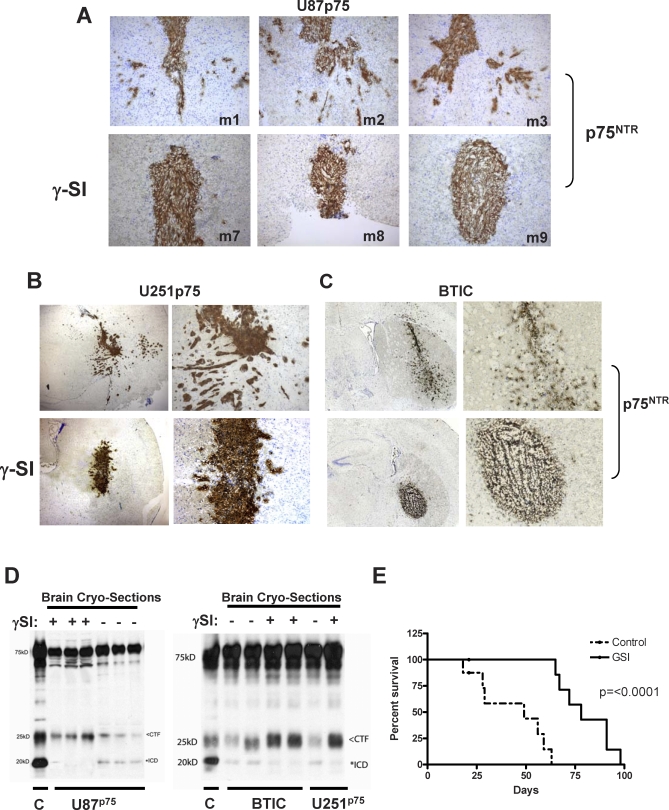
γ-Secretase Inhibitor Significantly Blocked p75NTR Induced Glioma Migration and Invasion In Vivo(A–C) u87p75NTR (A), U251p75NTR (B), or p75NTR-positive BTICs established from a patient GBM specimen (C) were implanted intracerebrally into SCID mice (m1–m3 and m7–m9 represent individual mice). Three days (U87p75NTR and U251p75NTR) or 5 d (BTIC) later, mice were administered s.c. 10 mg/kg γ-secretase inhibitor DAPT (γ-SI) or vehicle (corn oil) alone, once/day for 2–3 wk (three to five mice/group). The mice were sacrificed, and frozen brain sections were stained with an antibody against human p75NTR (brown). Sections were counterstained with toluidine blue to visualize the cell nucleus (blue). Control animals given vehicle alone (corn oil; middle row) developed tumors with highly infiltrative edges (top panels). In marked contrast, animals that received daily injections of the γ-secretase inhibitor DAPT (bottom panels) developed localized tumors with demarcated edges. Similar results were seen in two independent experiments with three to five animals in each group.(D) γ-Secretase inhibitor blocks p75NTR processing in vivo. Brain cryosections from three individual SCID mice implanted with u87p75NTR-, U251p75NTR-, or p75NTR-positive BTICs and administered s.c. 10 mg/kg γ-secretase inhibitor DAPT or vehicle (corn oil) alone were lysed in 2× loading buffer. Proteins were resolved on 10% SDS-PAGE gels and probed with a p75 cytoplasmic-specific antibody. In animals given vehicle alone, western blot analysis detected p75NTR-positive fragments migrating at 75, 24, and 19 kDa, whereas in cryosections from animals given the γ-secretase inhibitor DAPT, only the full-length p75NTR and 25-kDa CTF were detected. U87 cells expressing p75NTR and grown in the presence of epoxomicin (control; C) were used as a positive control. (The less than symbol [<] indicates CTF; the asterisk [*] indicates ICD.)(E) γ-Secretase inhibitor increases survival of animals bearing U87p75NTR xenografts. Kaplan-Meier survival curves of SCID mice harboring U87p75NTR intracranial tumors given s.c. injections of 10 mg/kg γ-secretase inhibitor DAPT or vehicle (corn oil) alone, once/day beginning on day 3. Animals given the γ-secretase inhibitor (GSI) survived significantly longer than control animals (p < 0.0001).